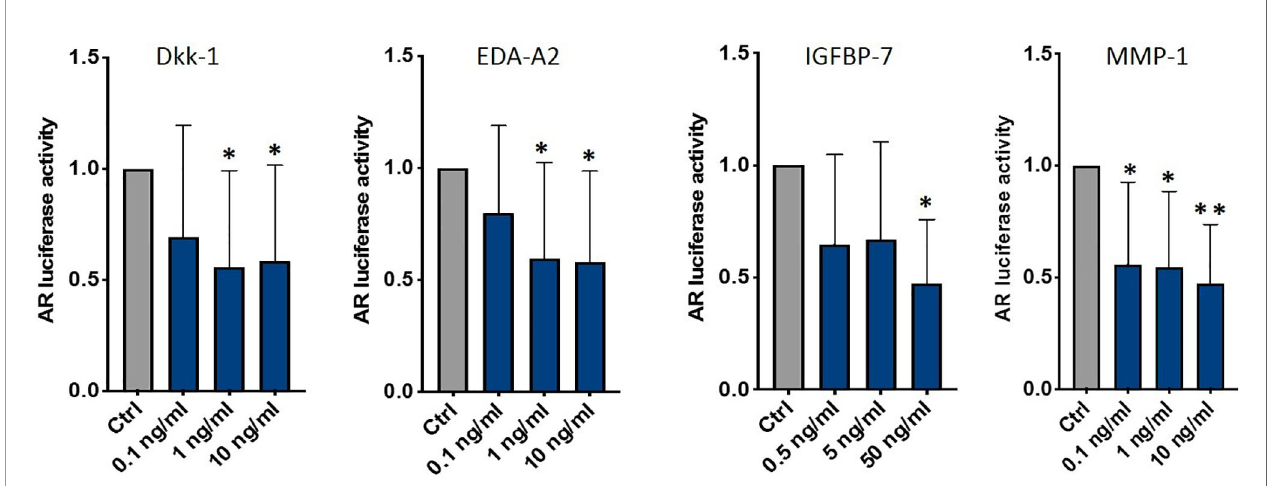
FIGURE 7 | AR activity of C4-2B FR cultured in C4-2B CM supplemented with DKK-1, EDA-A2, IGFBP-7, and MMP-1; * p < 0.05; ** p <